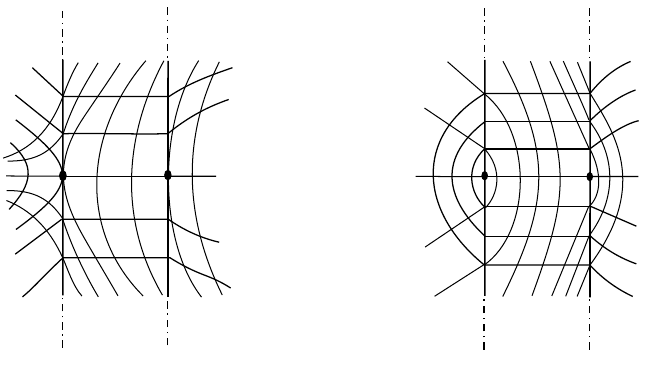
Fig. 3 – Piecewise Smooth Principal configuration of S (cid:20) : internal and external tangency. (resp. maximal) tangencies with B (cid:20) when (cid:20) > 0 (resp. when (cid:20) < 0). The piecewise smooth leaves are defined by continuation of the principal lines on the tube and parallel surfaces, crossing through S (cid:20), ± . In this context the external, E , and internal, I , minimal tangencies give rise to local and D configurations topologically equivalent to those around D 1 3